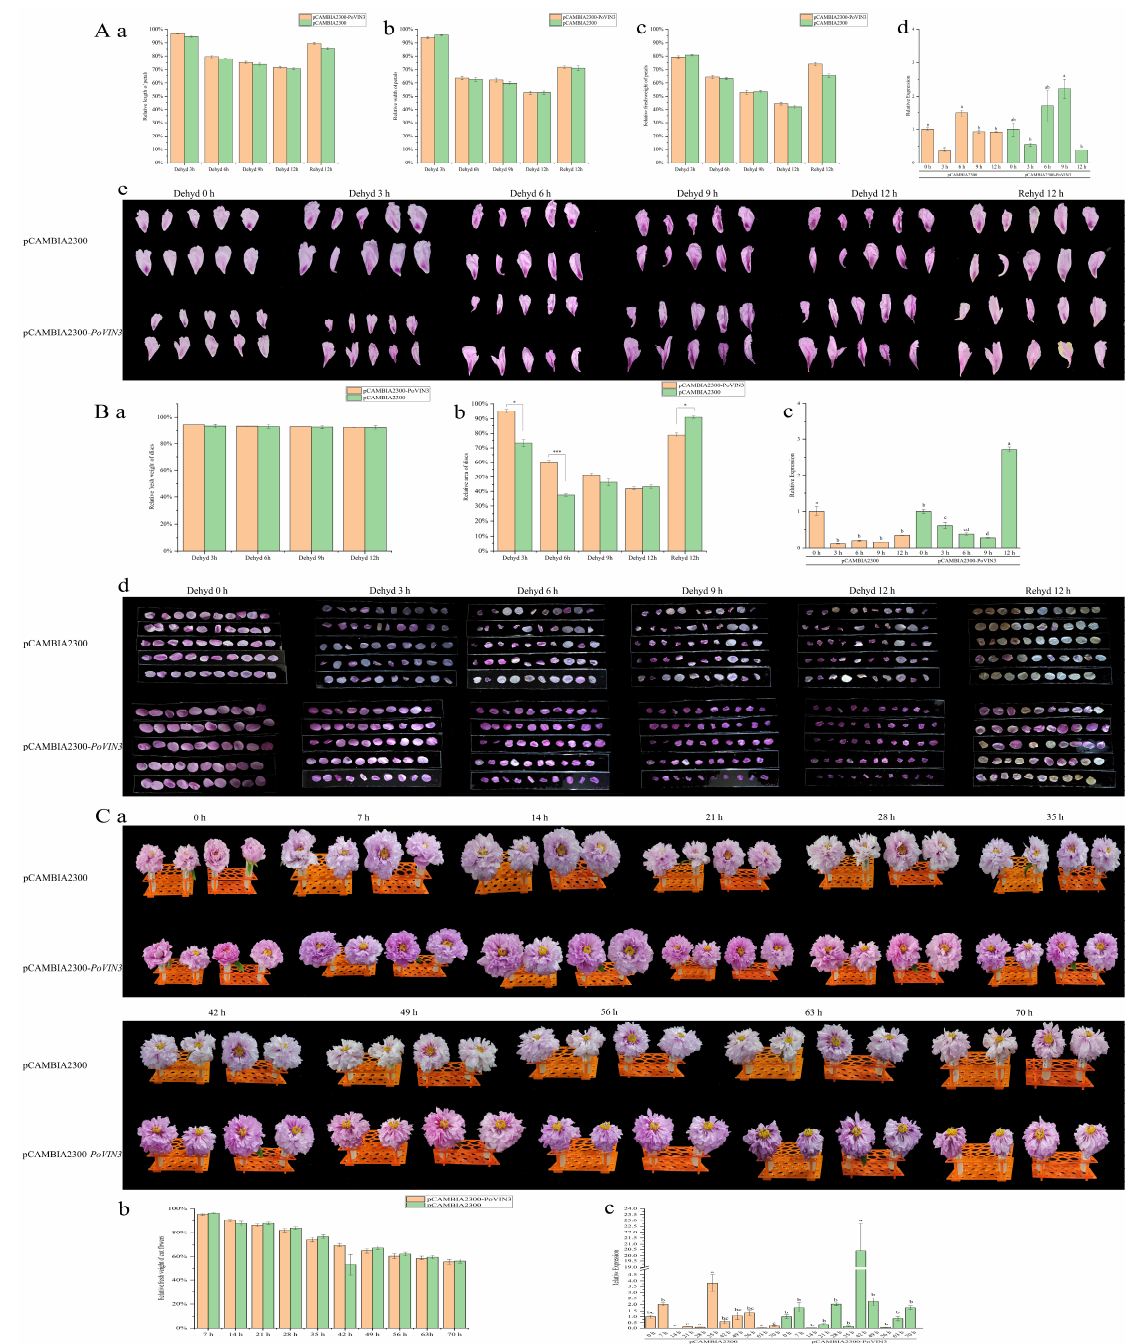
Figure 6. Transient expression of PoVIN3 was overexpressed in tree peony petals, discs, or fresh-cut flowers. ( A ) Tree peony petals were infiltrated with Agrobacterium tumefaciens containing pCAM- BIA2300 control and pCAMBIA2300- PoVIN3 for dehydration (0, 3, 6, 9, 12 h) and rehydration for 12h. The relative length ( a ), relative width ( b ), relative fresh weight ( c ), relative expression ( d ), and pheno- type ( e ) of petals were analyzed. ( B ) Phenotype and recovery of PoVIN3 -overexpressed petal discs. The relative fresh weight ( a ), relative area ( b ), relative expression ( c ), and phenotype ( d ) of petal discs were analyzed. ( C ) Overexpression infection in fresh cut flowers of tree peony. The phenotype ( a ), relative fresh weight ( b ), and relative expression ( c ) of fresh cut flowers were analyzed. Error bars represent standard error (SE). Different lowercase letters (a–d) indicate significant differences at p < 0.05, * means p < 0.05, and *** means p <